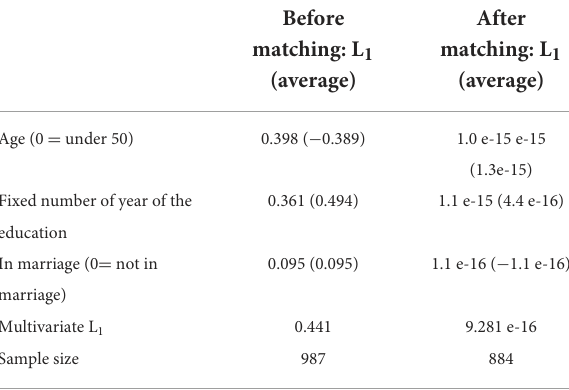
TABLE 3 Imbalance index L 1 before and after